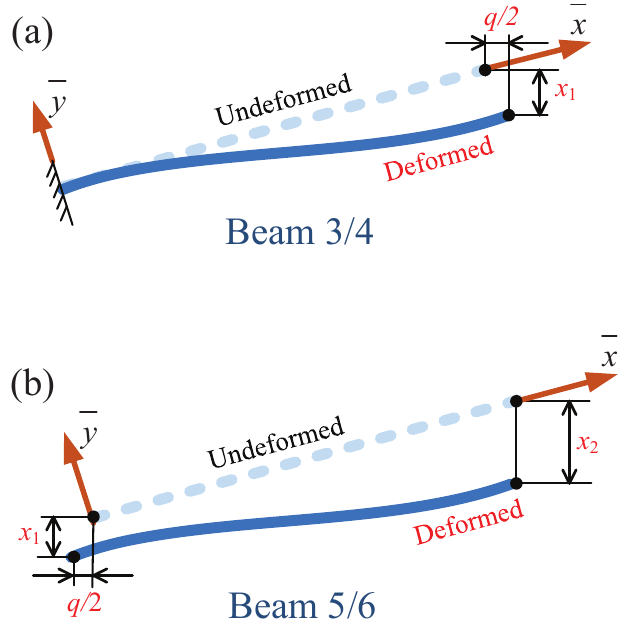
Figure 6. Deformation curves of beam flexures. ( a ) Beam 3/4. ( b ) Beam